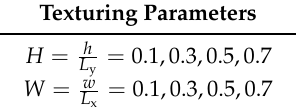
Table 1. Definition of computing parameters. Texturing